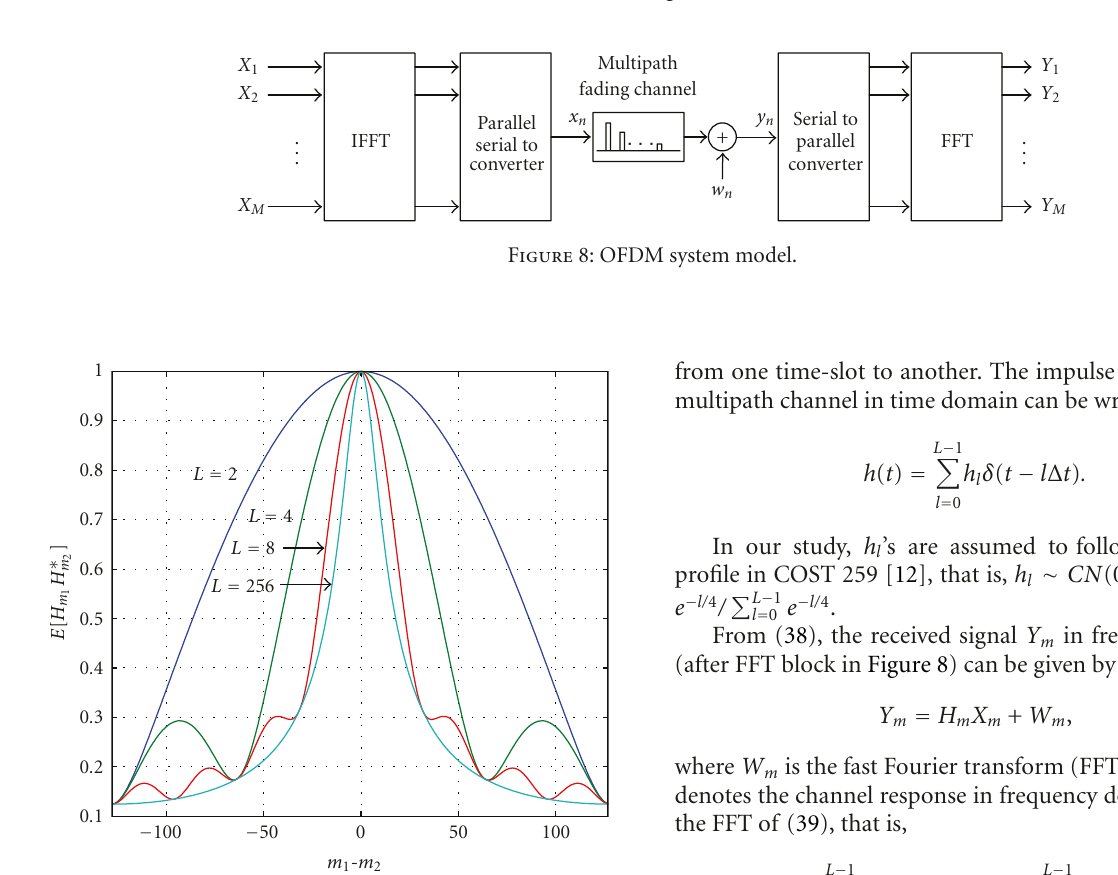
Figure 9: Correlation between OFDM